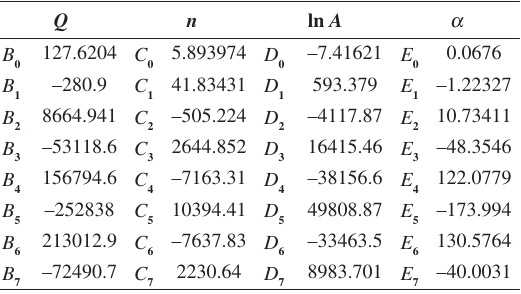
5.893974 D 0 41.83431 D 1